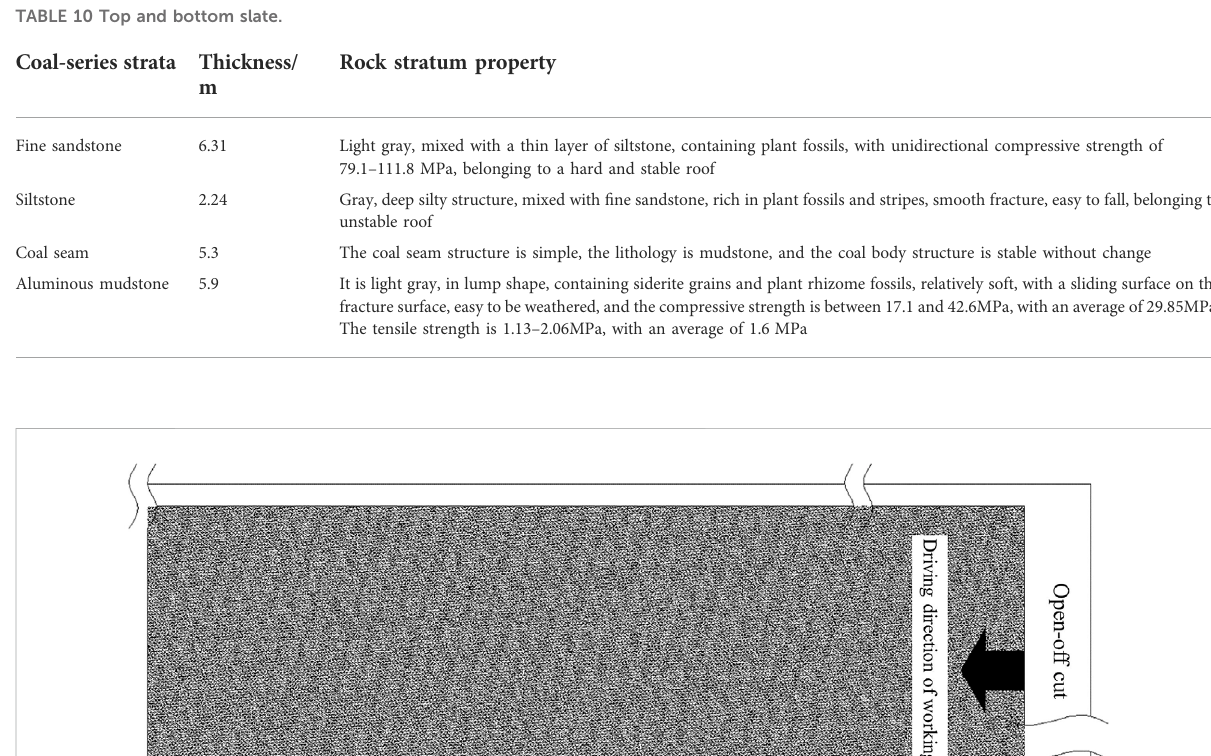
TABLE 10 Top and bottom slate.